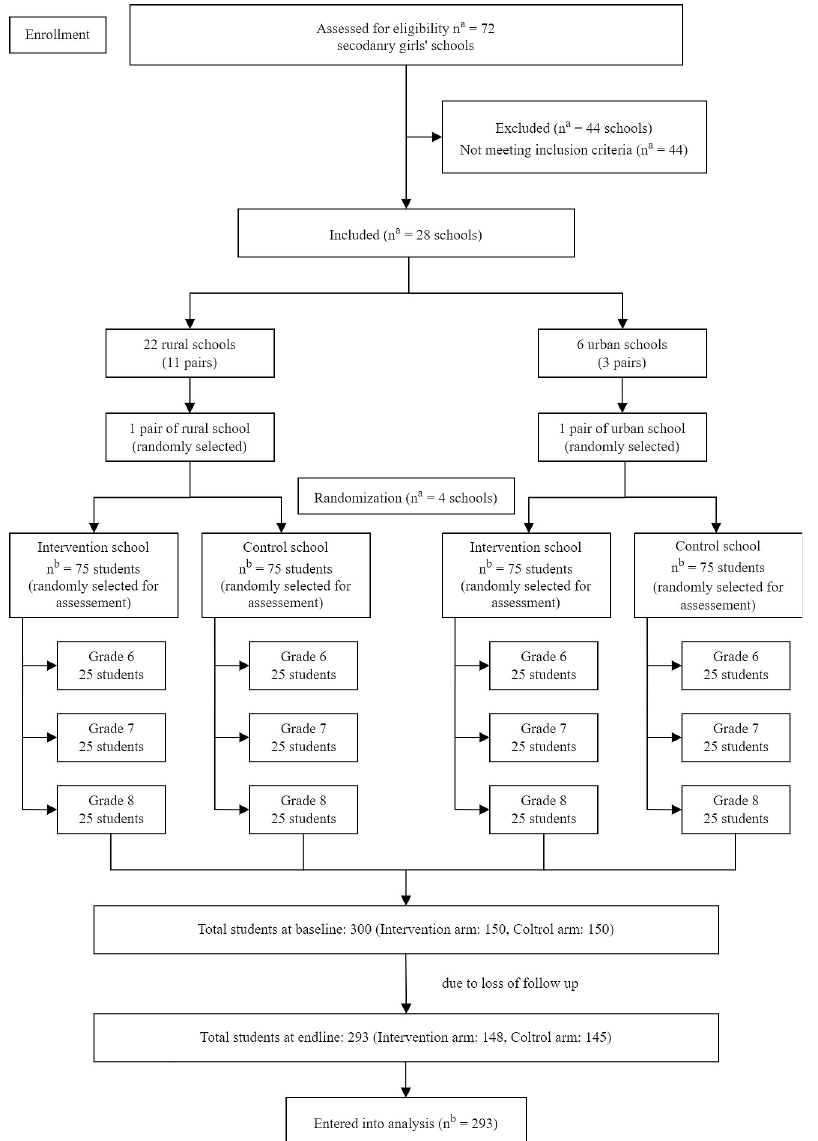
Fig 1. Trial flow diagram. (a) cluster (school). (b)